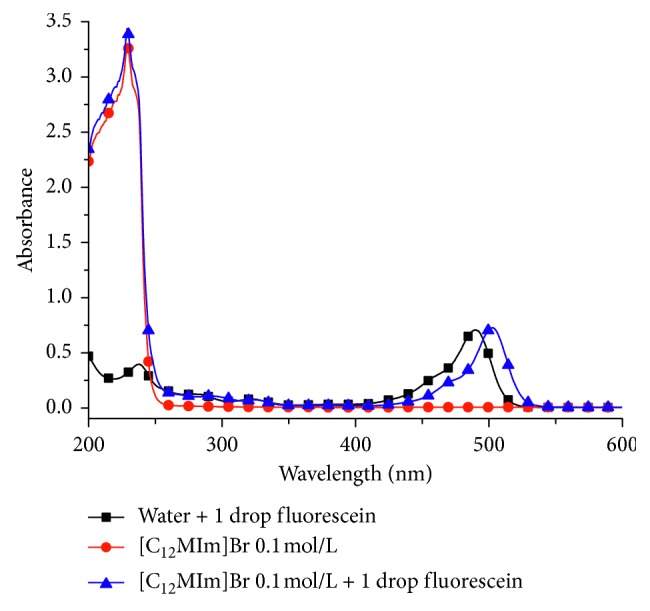
UV-Vis spectrum and the maximum absorption wavelength for fluorescein and/or [C12MIm]Br at 0.1 mol/L.